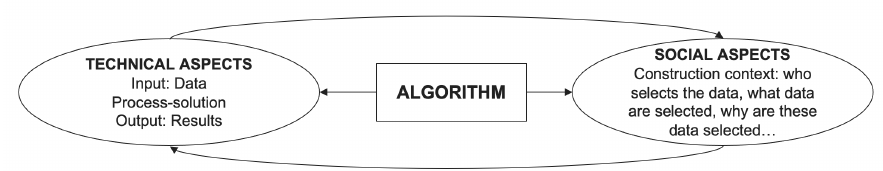
Figure 3. Socio-technical definition of the algorithm